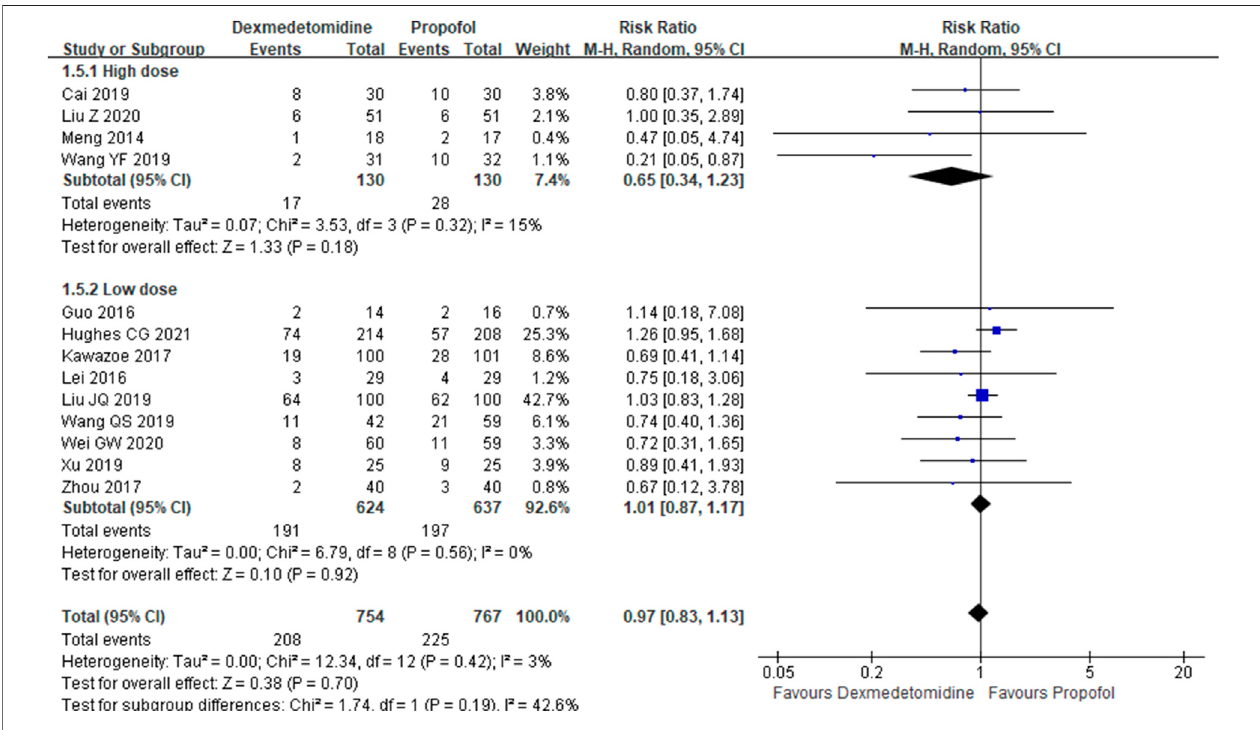
FIGURE 4 | Forest plot of duration of mechanical ventilation.